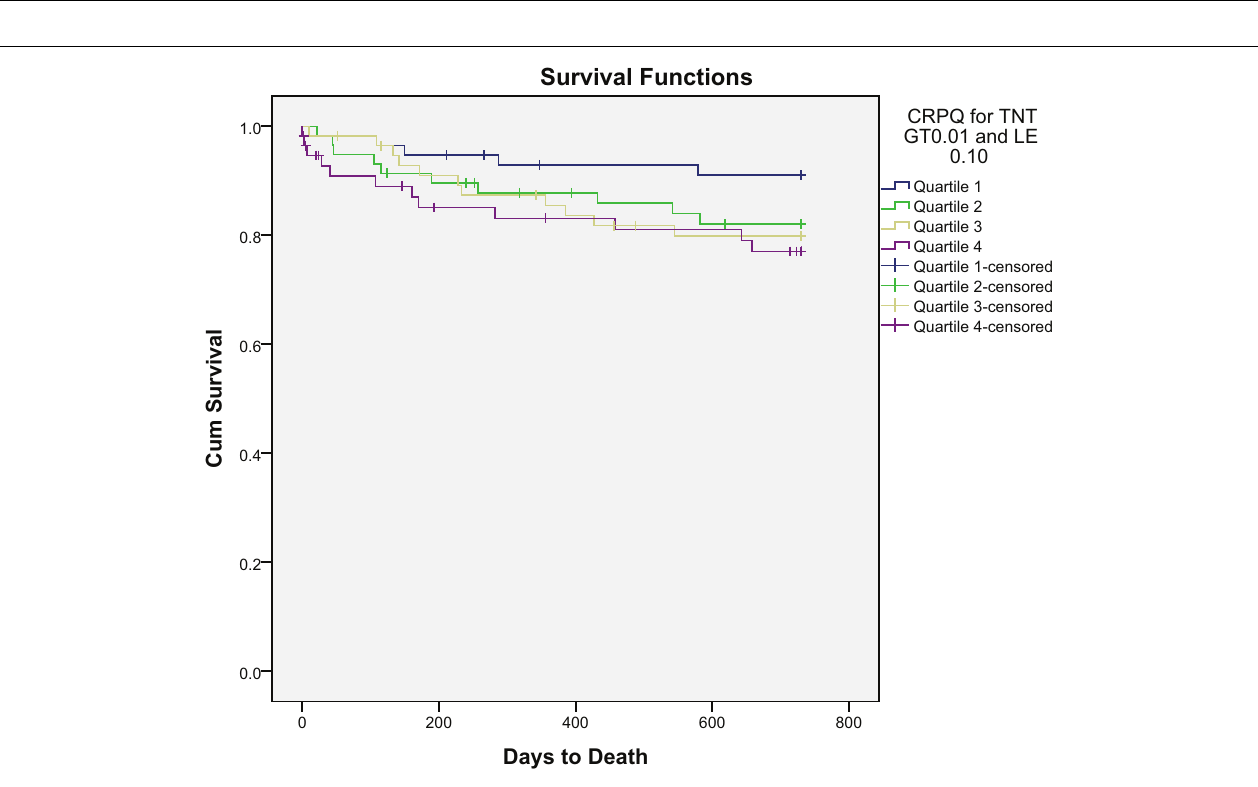
FIGURE 4 | Kaplan–Meier plot of time to cardiac death within 2years by BNP quartiles .